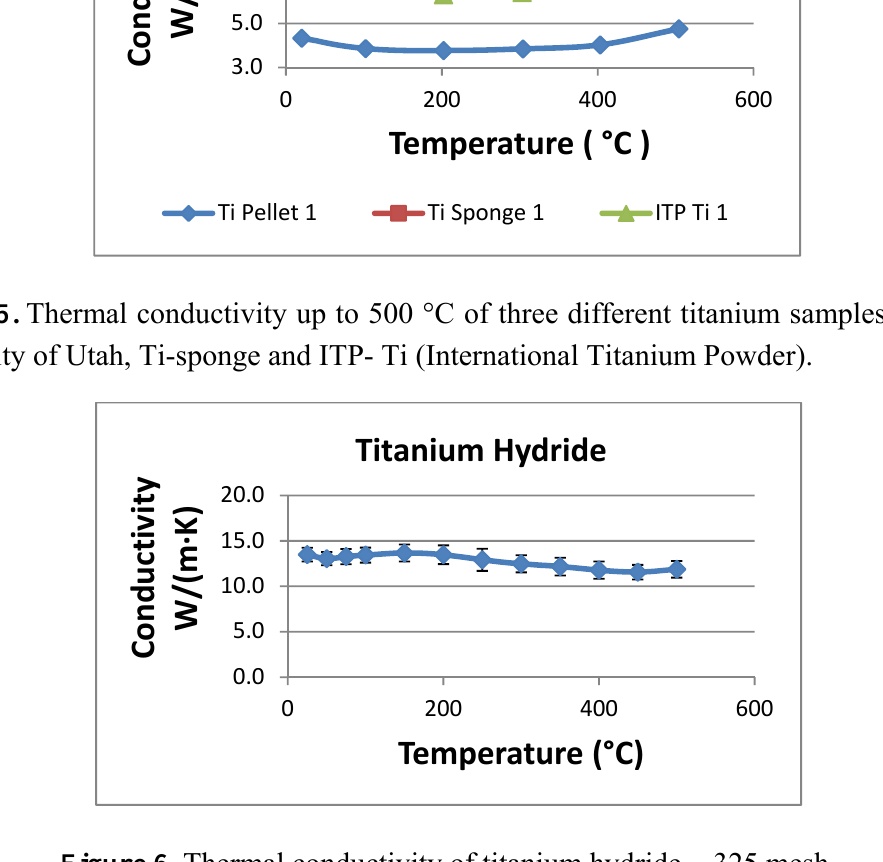
Figure 6. Thermal conductivity of titanium hydride, − 325